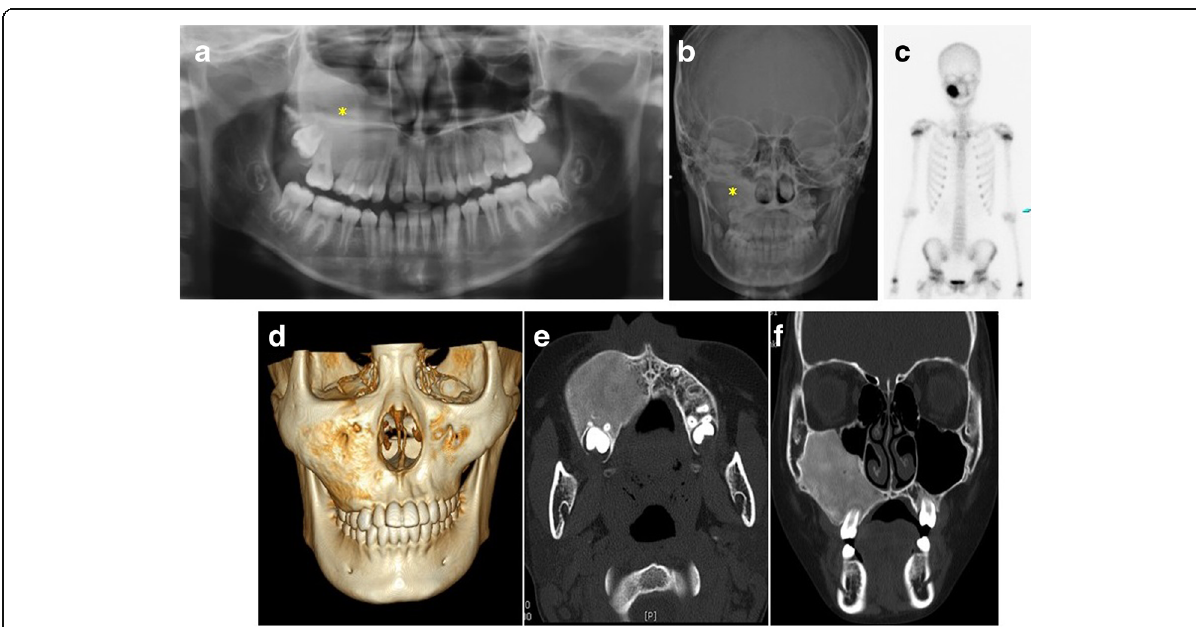
Fig. 2 Preoperative radiographic images. a Panoramic view showed a high bone density on the right maxilla and zygoma and obliteration of the right maxillary sinus (asterisk indicates the fibrous dysplasia lesions). Additionally, the development of tooth germ was observed in the lesion. b Posteroanterior (PA) cephalometric view also showed an increased bone density on the right maxillary area and an asymmetric facial contour. c Bone scan showed an irregularly shaped hot uptake in the right maxilla, and no abnormally increased uptake was observed in any other sites. d